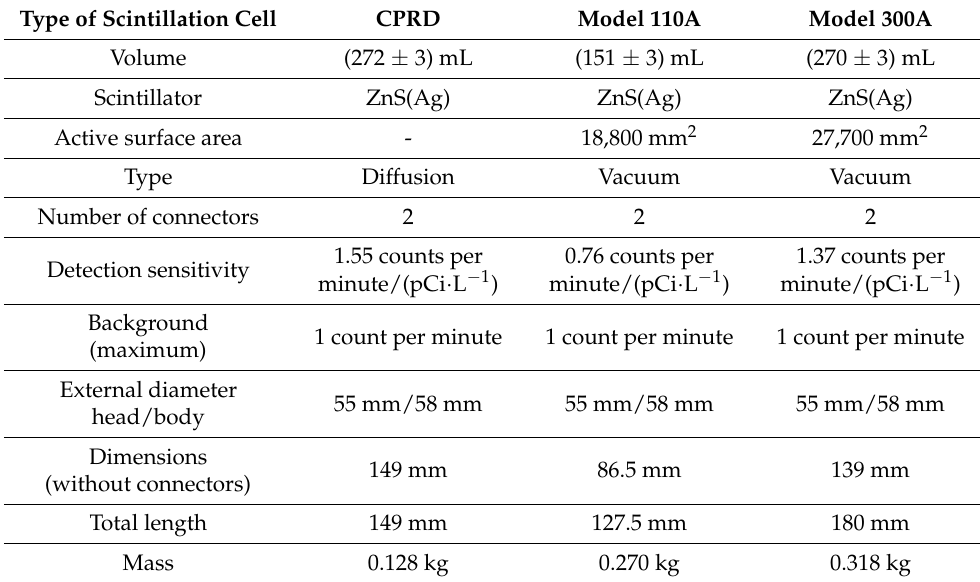
Table 2. The main characteristics of the Pylon AB5 radon monitor [22] (IFIN-HH/DFVM/SALMROM). Type of Scintillation Cell CPRD Model 110A Model 300A